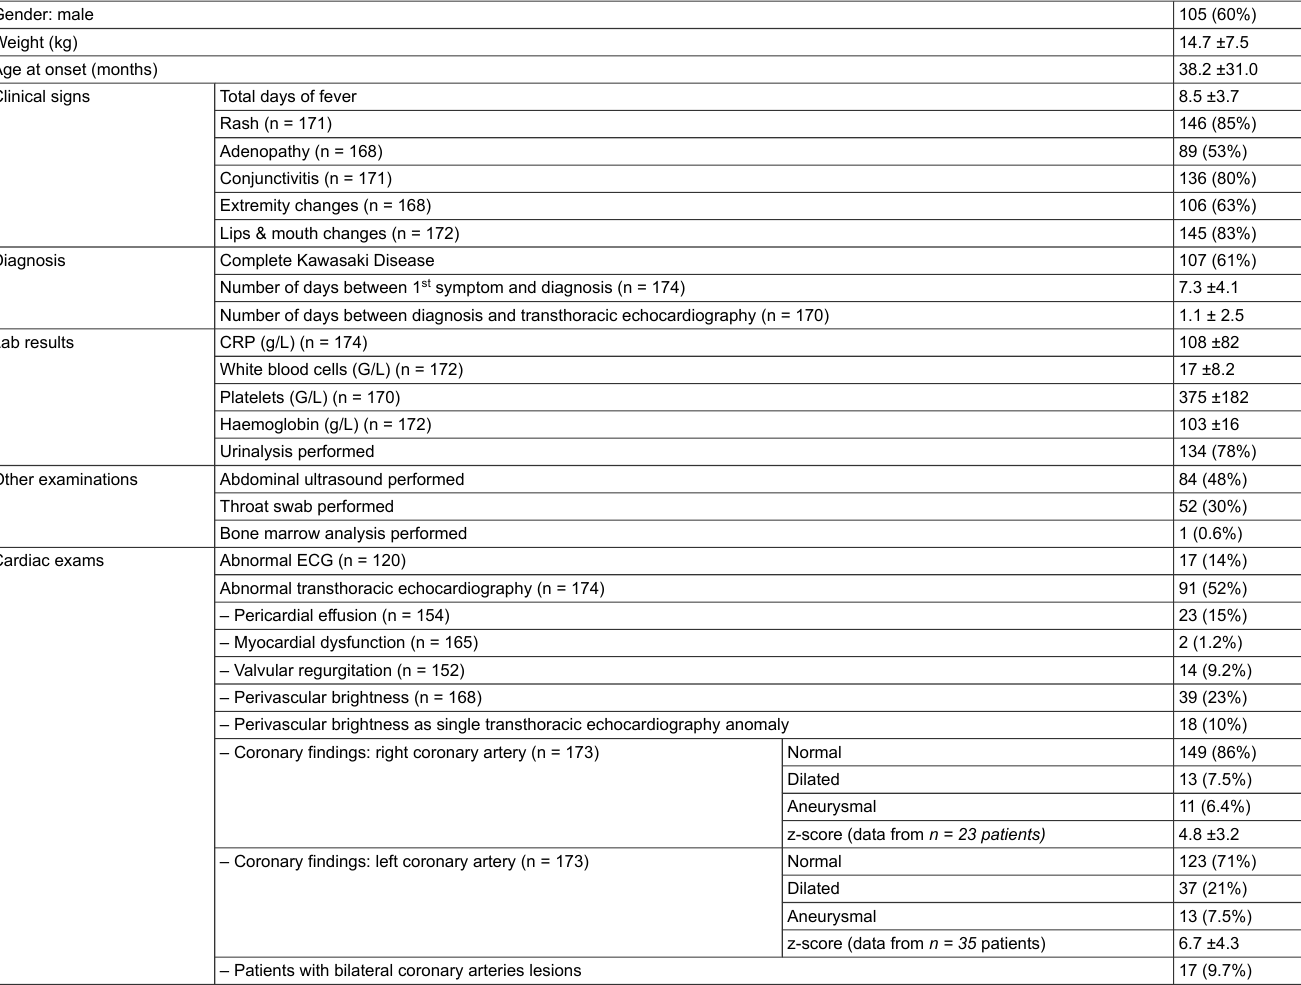
Table 1: Baseline characteristics. Data are provided as mean and standard deviation, respectively as absolute number and percentage, as appropriate. All patients: n = 175. Gender: